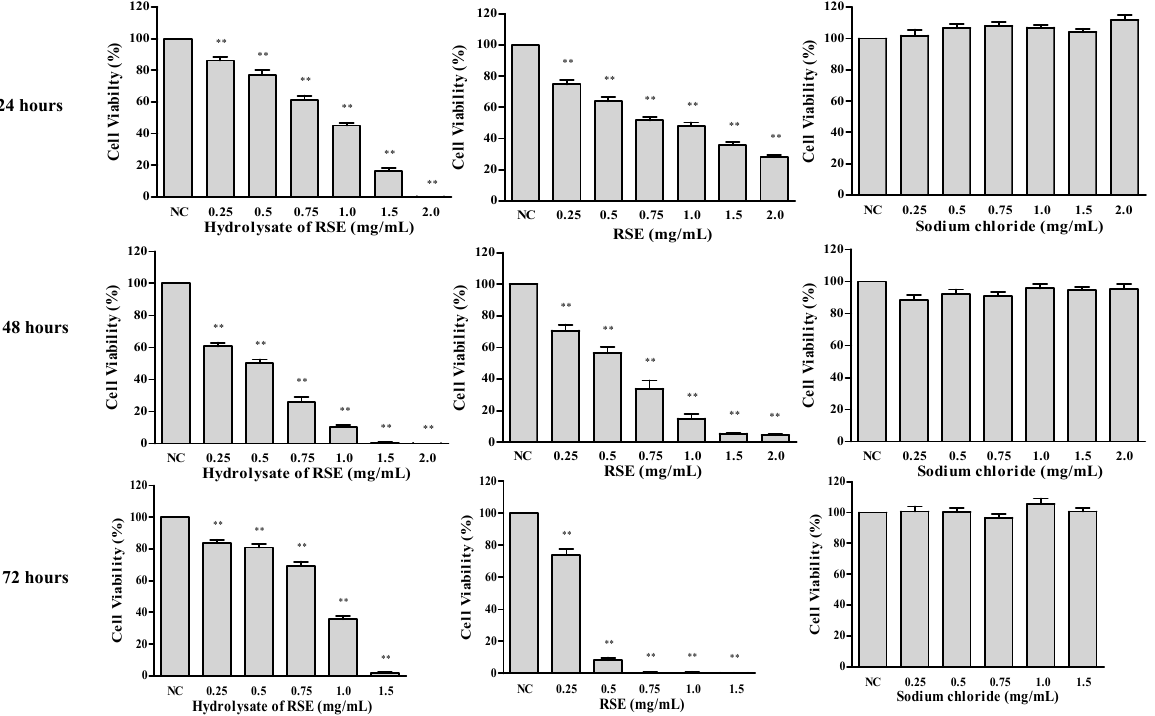
Figure 2. Time- and dose-dependent cytotoxicity of RSEH and RSE on LLC1